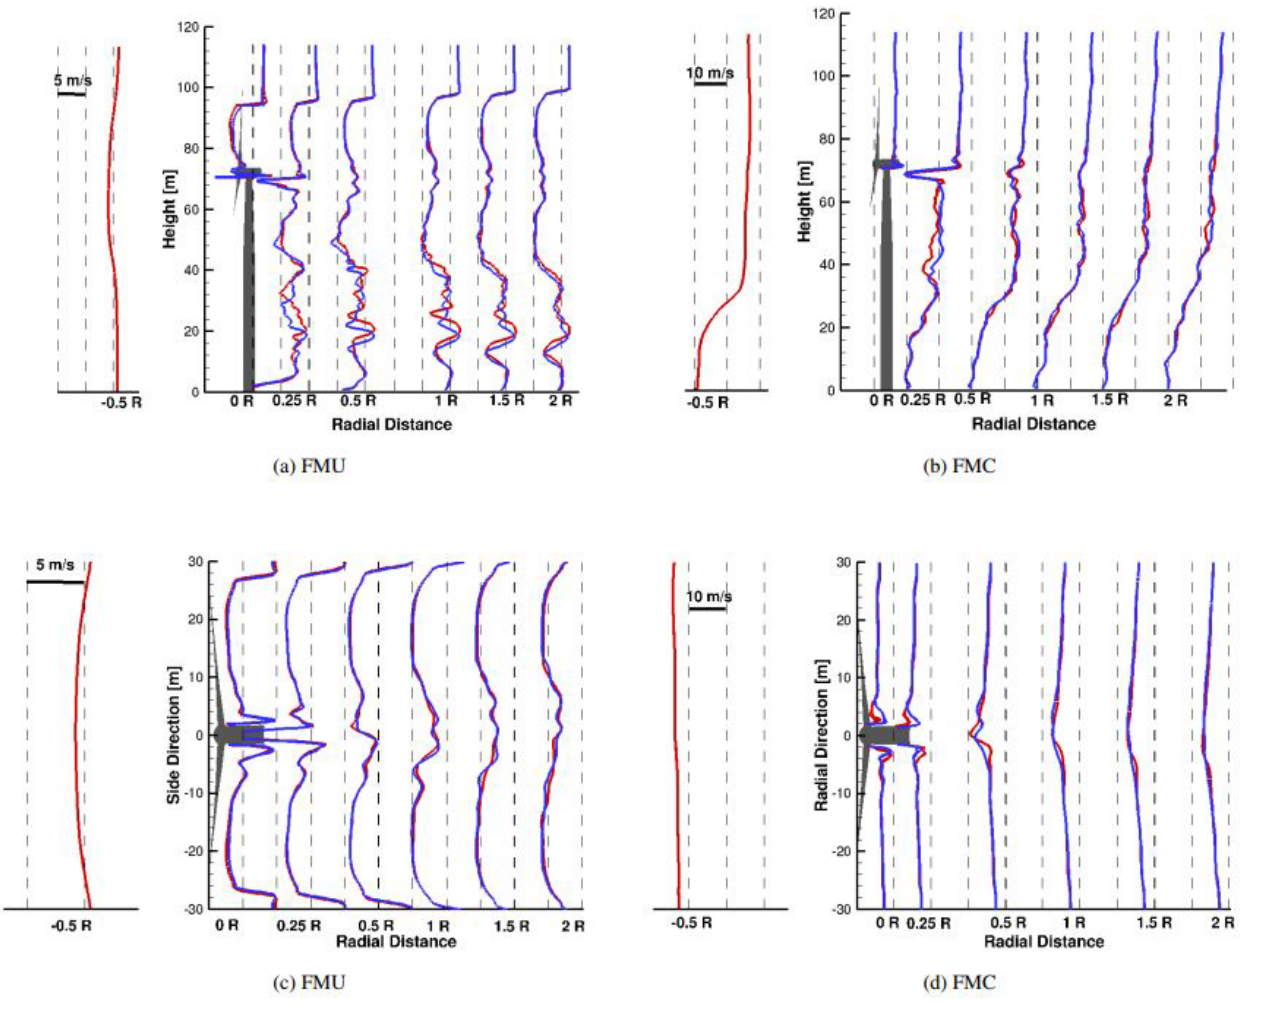
Figure 10. Profiles of the velocity component in the wind direction at different axial distances from the tower center. x – z (flow direction– height) slices in (a) and (b) and x – y (flow–side direction) slices in (c) and (d) , including the averaged inflow slice. Red lines represent the rigid case and blue lines the beam-coupled